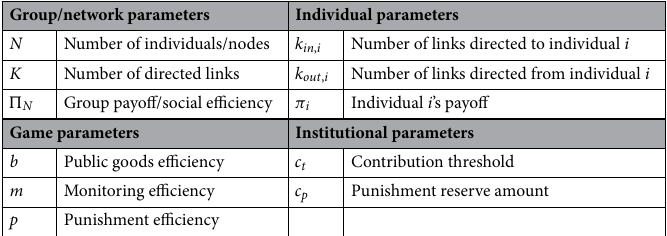
Table 1. Summary of model